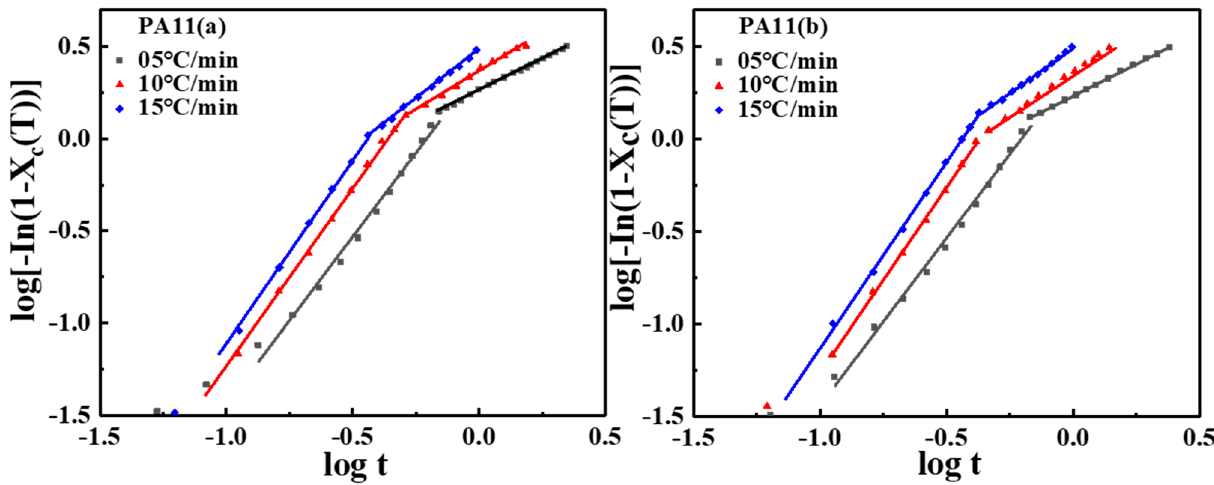
Figure 6. Plot of 𝑙𝑜𝑔(cid:4670) ﹣ 𝐼𝑛(1 ﹣ 𝑋 (cid:3030) (𝑡))(cid:4671) versus 𝑙𝑜𝑔𝑡 for the non-isothermal crystallization process of Figure 6. Plot of log [ − In ( 1 − X c ( t ))] versus logt for the non-isothermal crystallization process of PA11 samples. PA11 samples. Table 2. Avrami constants for all samples at various cooling rates.